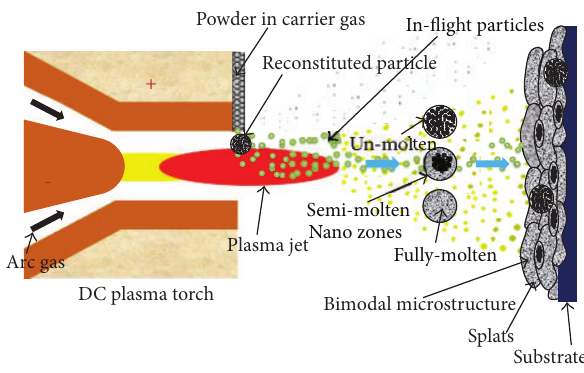
Figure 1: Schematic diagram of plasma spray coating process using nanostructured